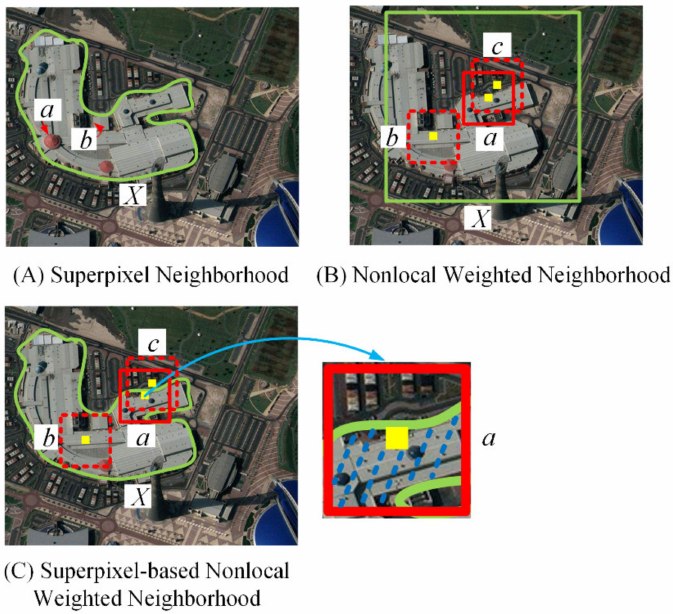
Figure 1. The illustration of different neighborhoods in JSRC: ( A ) superpixel neighborhood, ( B ) non- local weighted neighborhood, and ( C ) superpixel-based nonlocal weighted neighborhood. Three points a – c are pixels; a is a testing pixel, and b and c are neighboring pixels. X is the neighborhood of pixel a , and it is a superpixel in ( A , C ) and a square block in ( B